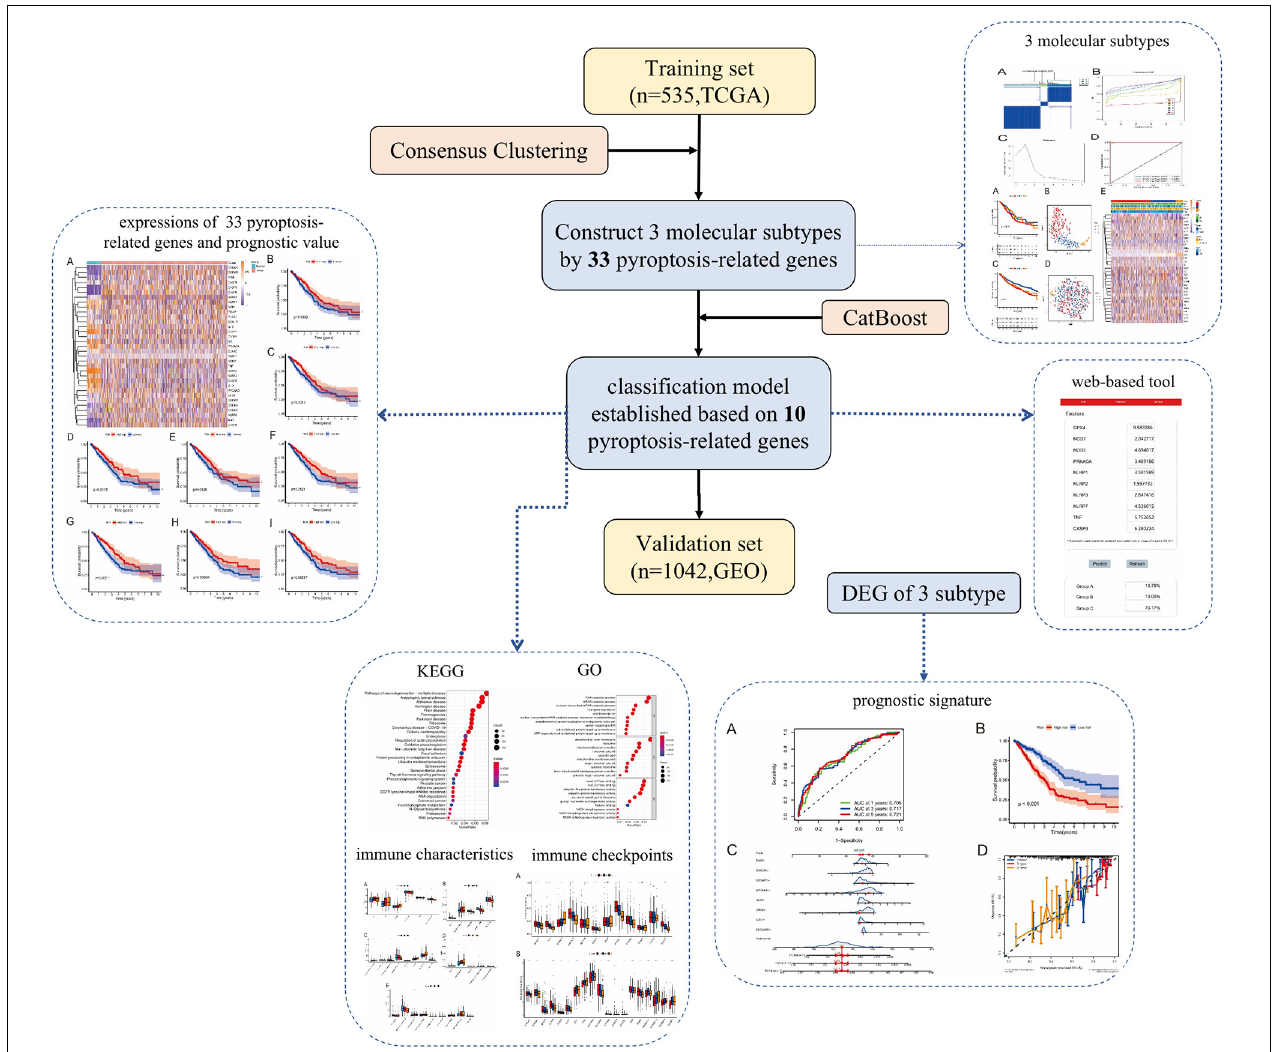
FIGURE 1 | Article framework and workflow. TCGA, the cancer genome atlas database; GEO, gene expression omnibus Database; DEG, differentially expressed genes; CatBoost, categorical boosting; KEGG, kyoto encyclopedia of genes and genomes; GO, gene